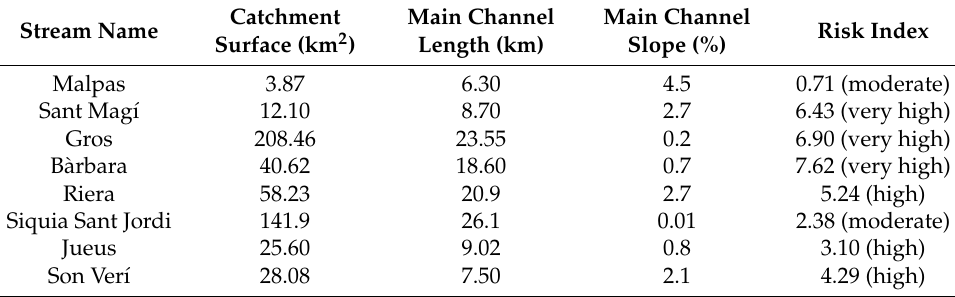
Figure 1. Location of Palma within the island of Mallorca and its surface water network. Table 1. Characterization of the surface water network in Palma’s basin.